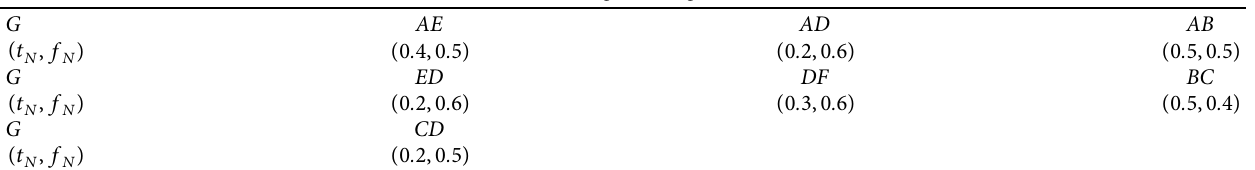
Table 4: Weight of edges in G